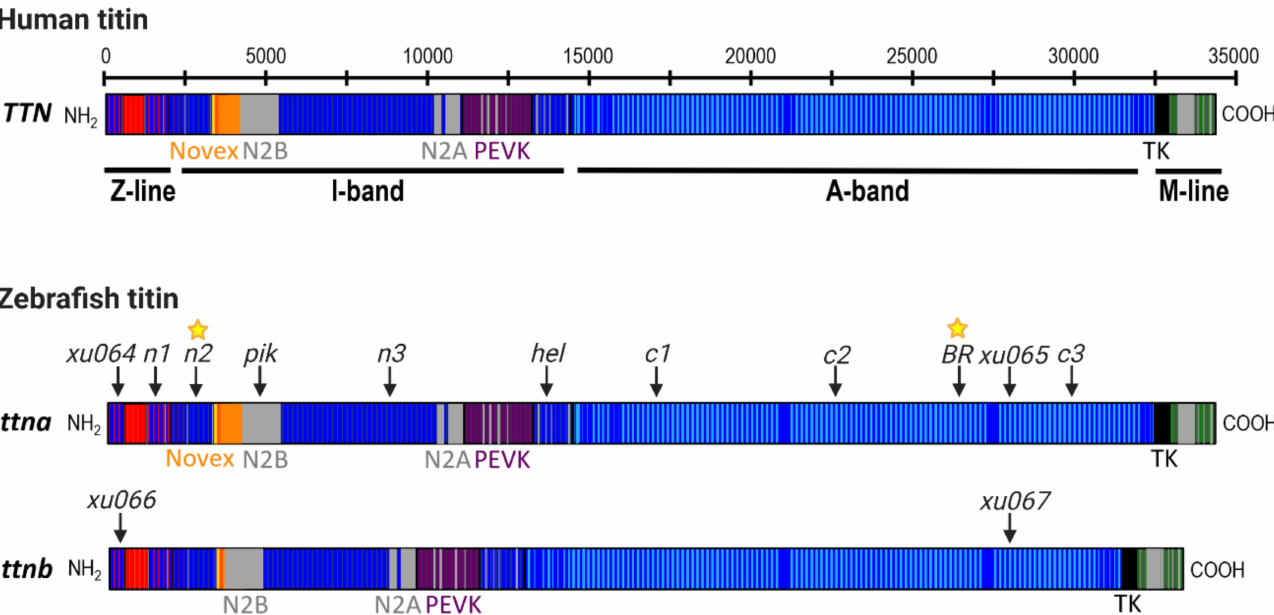
Figure 2. Schematic of the human TTN gene (meta-transcript) and the two zebrafish titin genes, ttna and ttnb . Titin contains four sub-domains (Z-line, I-band, A-band, M-line) that are conserved between humans and zebrafish. The locations of mutations in the zebrafish ttna and ttnb genes are indicated by arrows and labelled according to published mutant allele names (see Table 1 for more details). Phenotype data are available for embryonic mutants in all lines; yellow stars denote mutant lines in which cardiac function has also been evaluated in adult fish. Additional double mutant lines have also been generated by Shih et al. (2016) including xu068 , xu069 , xu070 and xu071 , each of which possesses different combinations of the xu064 , xu065 , xu066 and xu067 alleles indicated in this figure (see Table 1 for more